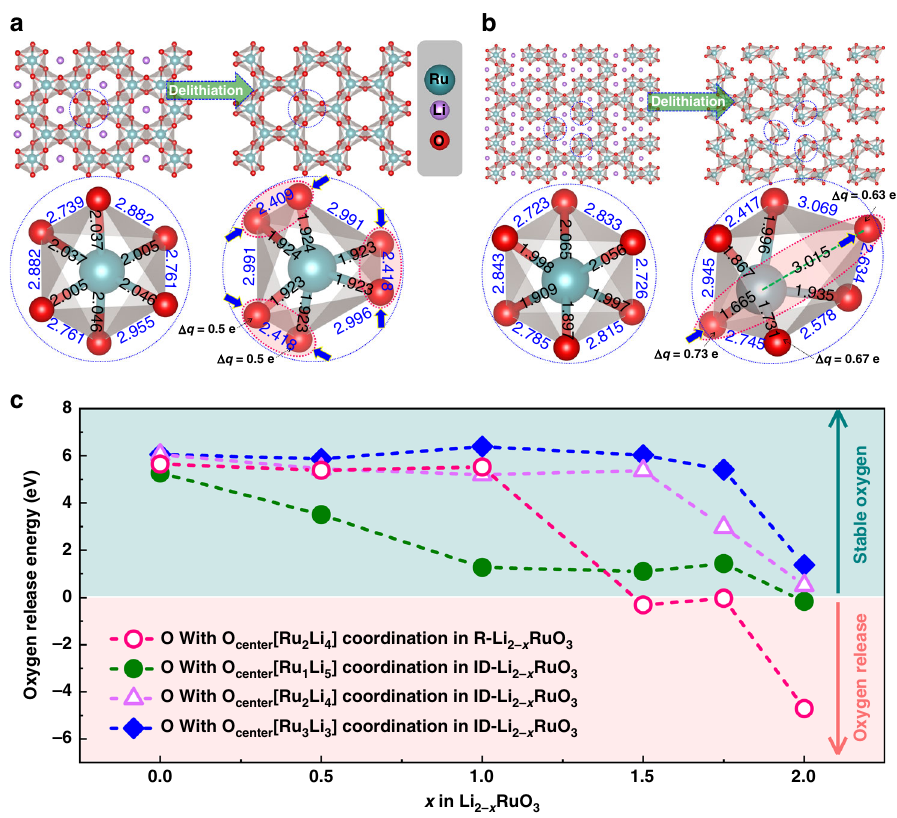
Fig. 2 Crystal structures and oxygen stability upon delithiation. a , b Optimized crystal structures and local RuO 6 octahedrons of Li 2 RuO 3 and the corresponding delithiated state (Li 0 RuO 3 ) for R-Li 2 RuO 3 ( a ) and ID-Li 2 RuO 3 ( b ). The values (in angstrom) on the local structures are the Ru – O bond lengths and O – O distances. c Oxygen release energy for R-Li 2 − x RuO 3 and ID-Li 2 − x RuO 3